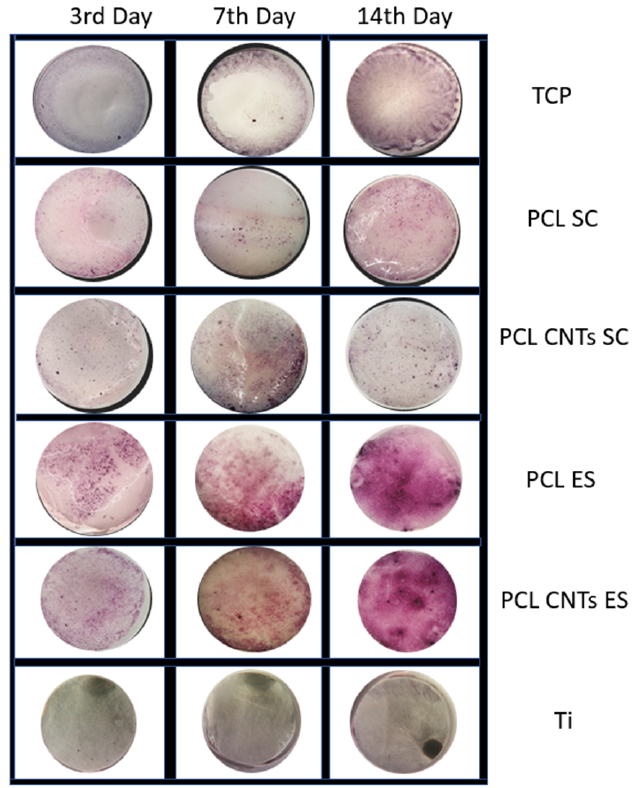
Figure 6. Cell proliferation: Quality MTT 3, 7, and 14 days of incubation on the different substrates.